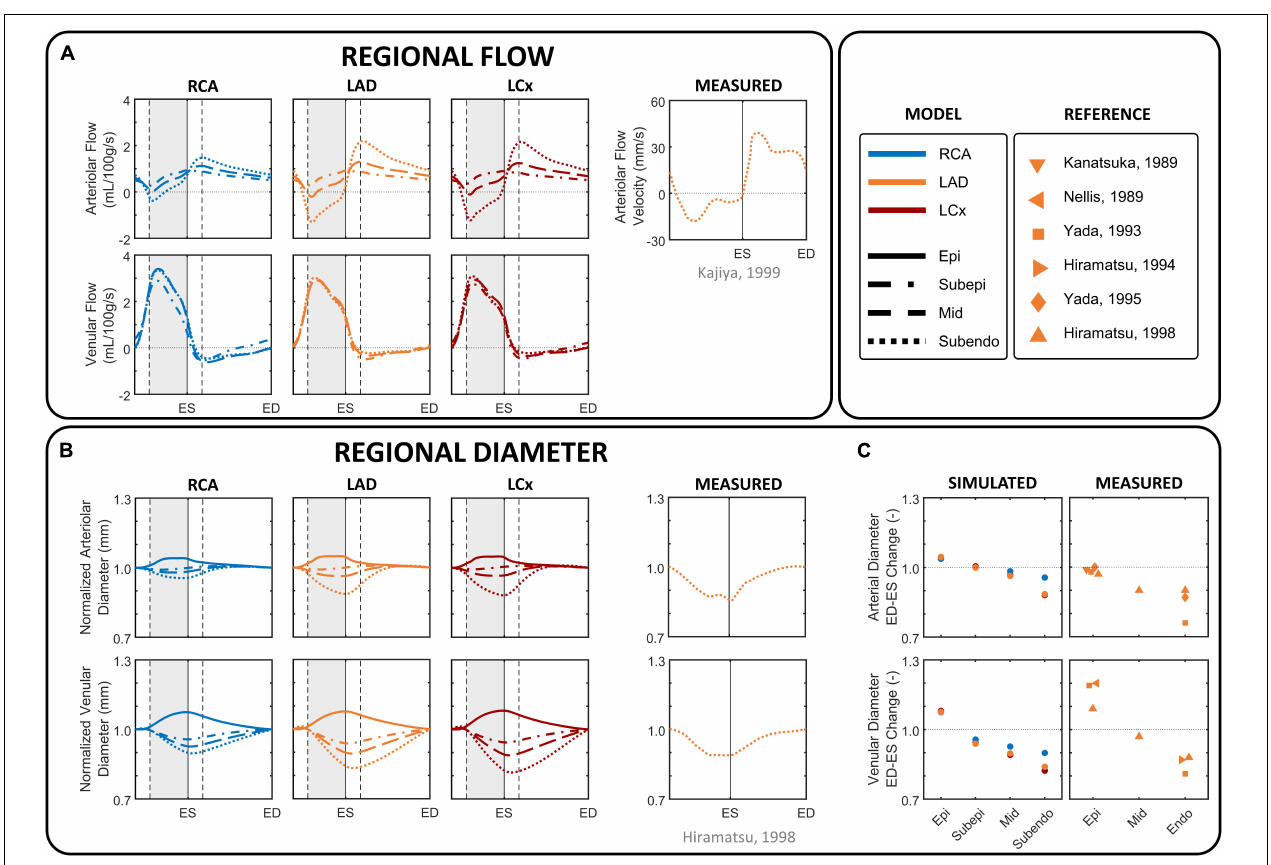
FIGURE 4 | Phasic changes in regional microvascular flow and diameter of arterioles and venules in different coronary layers. (A) Simulated arteriolar (R1) and venular (R2) intramyocardial flow in the subepicardial, mid-, and subendocardial layer during one cardiac cycle, together with arteriolar subendocardial flow measured in the left anterior descending (LAD) (Kajiya and Goto, 1999). (B) imulated intramyocardial diameter in the epicardial, subepicardial, mid-, and subendocardial layer during one cardiac cycle, together with normalized subendocardial diameter measured in the LAD (Hiramatsu et al., 1998). Simulated diameter changes were derived from the arteriolar and venular volumes, assuming a circular shape and constant length, normalized by the diameter at end-diastole to facilitate the evaluation of the amplitude of diameter change over the cardiac cycle. (C) Simulated percental change in diameter of epicardial (Epi), subepicardial, mid, and subendocardial arterioles and venules from end-diastole (ED) to end-systole (ES), together with measured data in the LAD (Kanatsuka et al., 1989; Nellis and Whitesell, 1989; Yada et al., 1993, 1995; Hiramatsu et al., 1994, 1998). Vertical gray areas indicate left ventricular ejection and vertical dashed/solid lines indicate opening/closing of left ventricular cardiac valves. LCx, left circumflec artery; RCA, right coronary